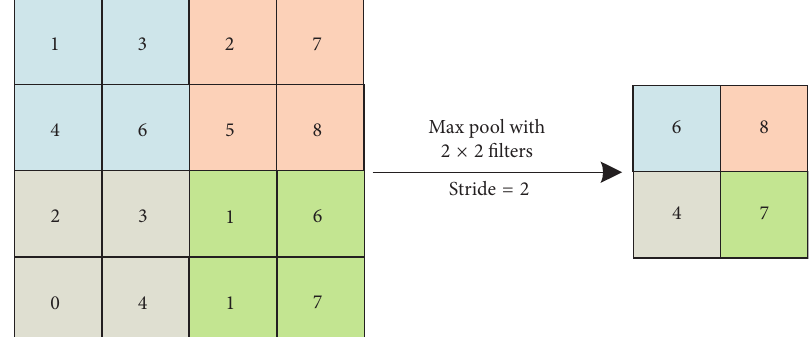
Figure 3: Schematic diagram of maximum pooling.